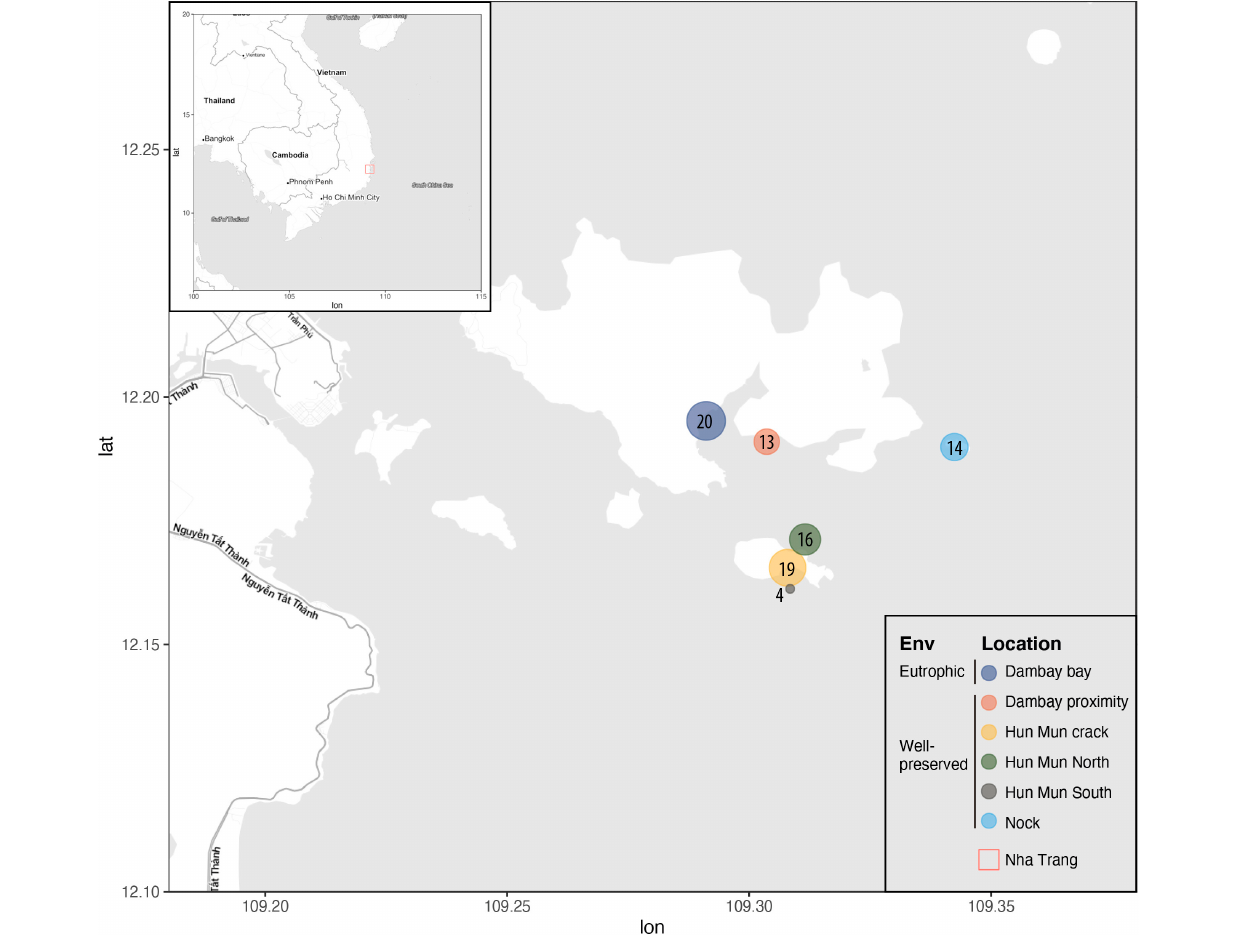
FIGURE 1 | Map of the sampling locations of Nha Trang Bay. All the islands within the sampling region belonged to the Marine Protected area (MPA). Size and number of the circles correspond to the number of samples (sponges) taken from each location, represented with different